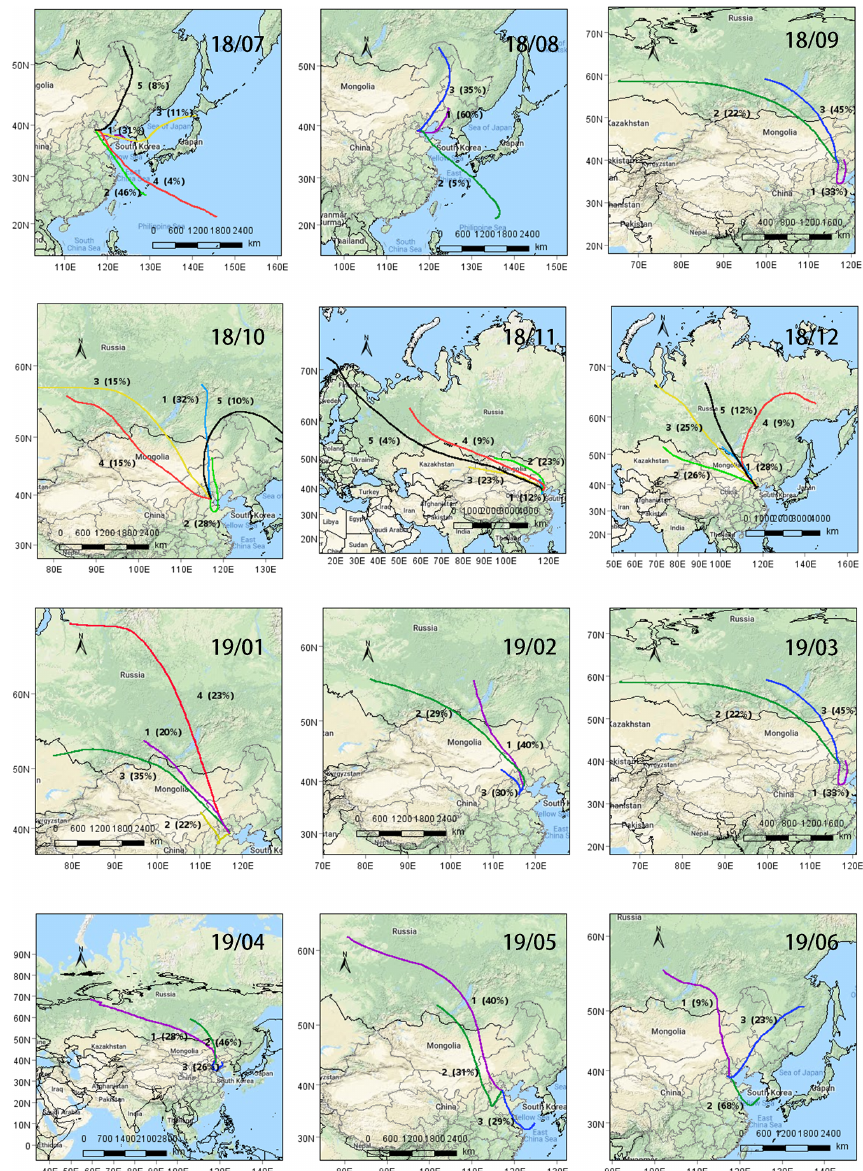
Figure 3. Monthly cluster analysis plots of 5d backward air mass trajectories arriving over Tianjin at 500ma.g.l. during the campaign period. (The maps were generated by the MeteoInfo software using © Google